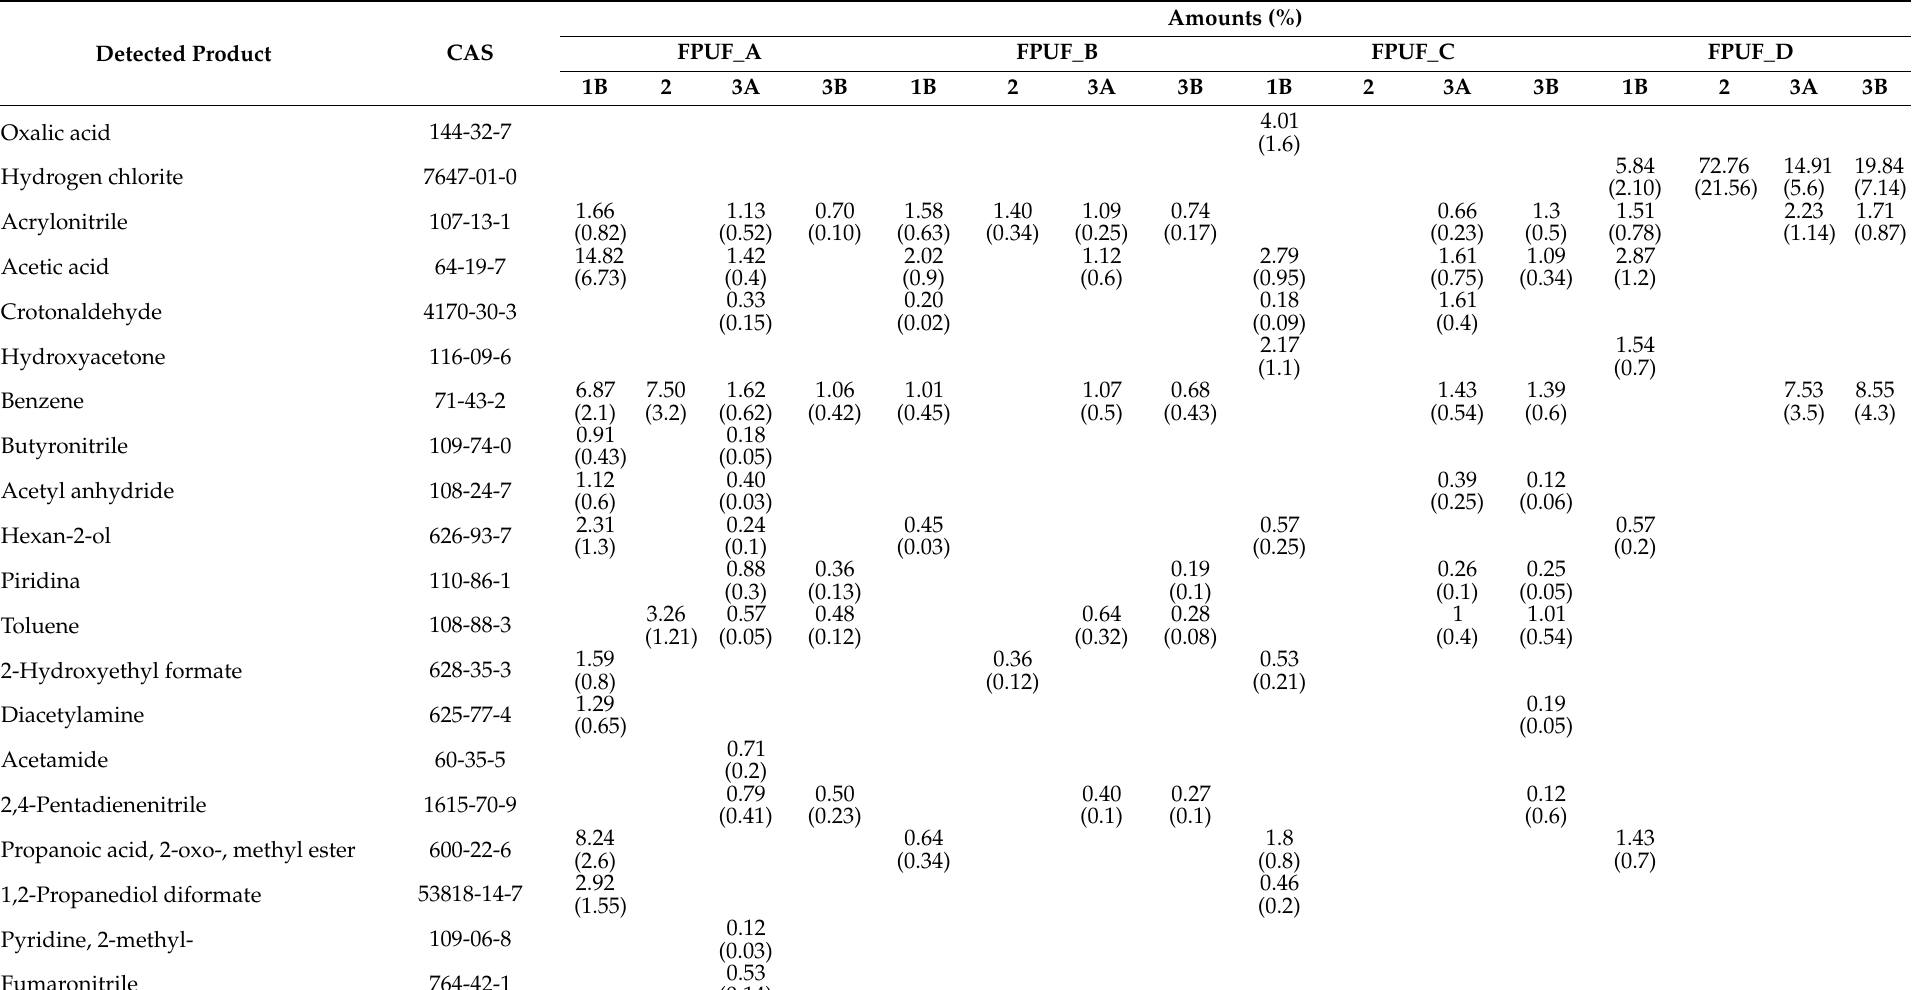
Table 5. List of products identified in fire effluents released during ~5 min steady-state periods during different fire